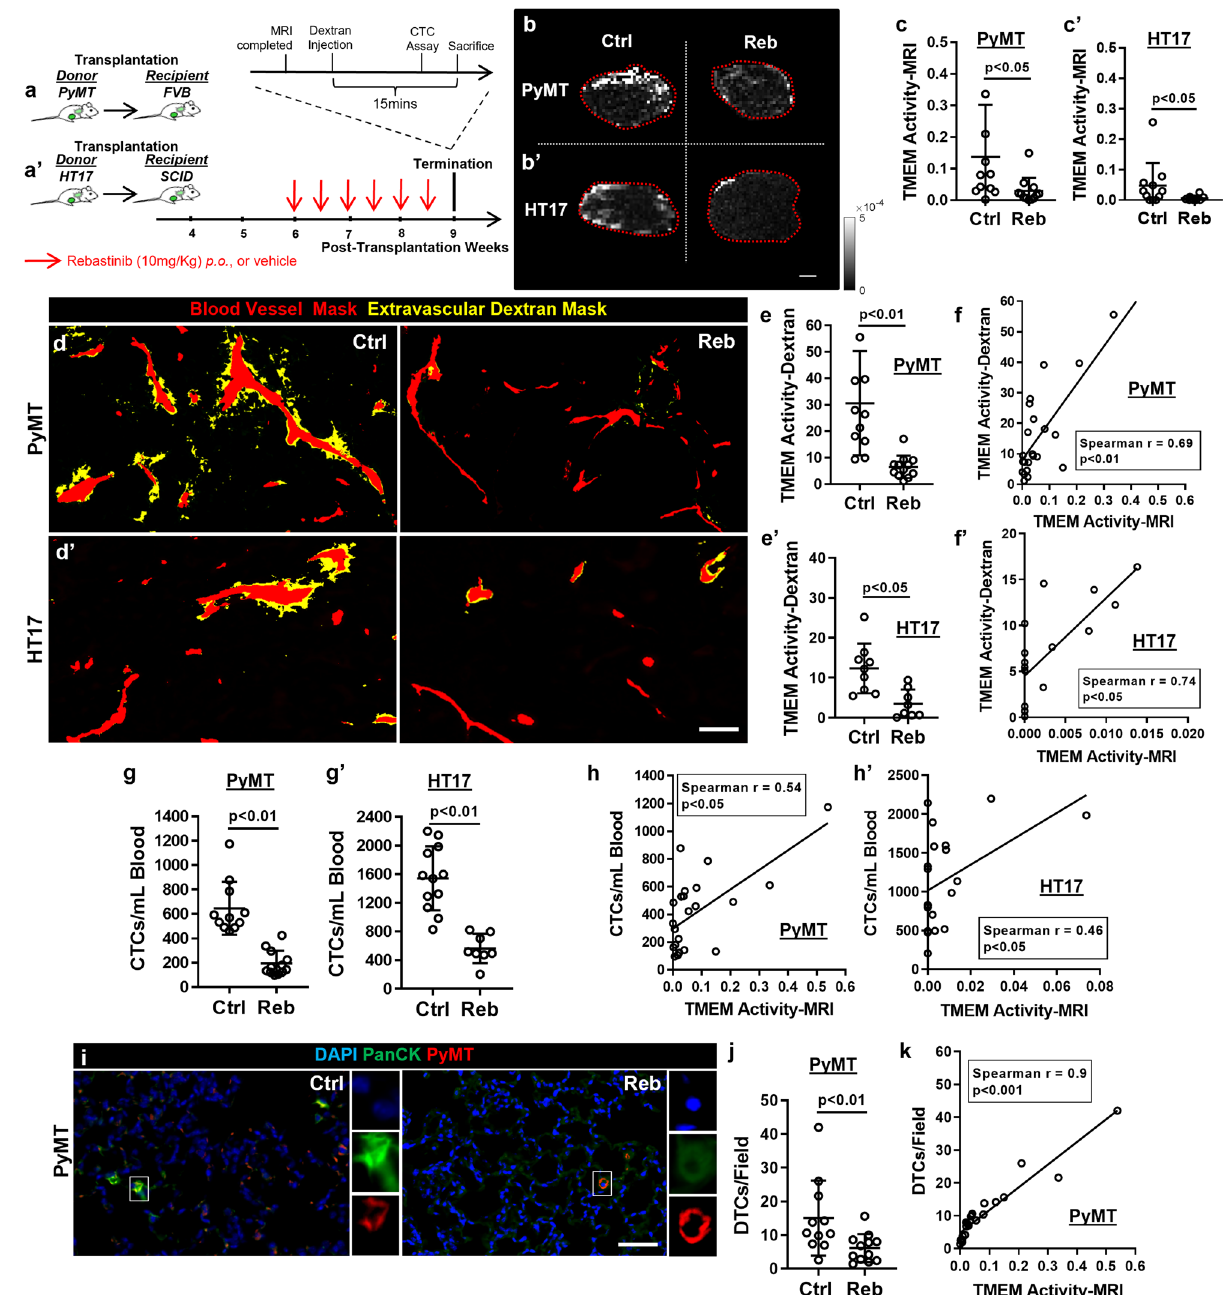
However, upon treatment of breast carcinomas with rebastinib, we did not observe any correlation between TMEM score and TMEM activity-MRI in either of the two models tested (Supple- mentary Fig. 5c). This observation was completely expected since rebastinib is known to inhibit TMEM doorway activity without affecting the assembly of new, or the breakdown of